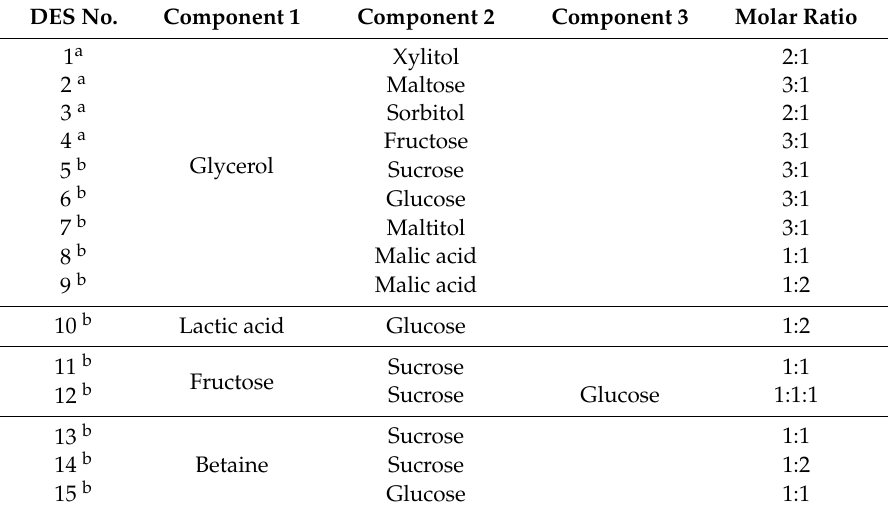
Table 1. List of synthesized deep eutectic solvents